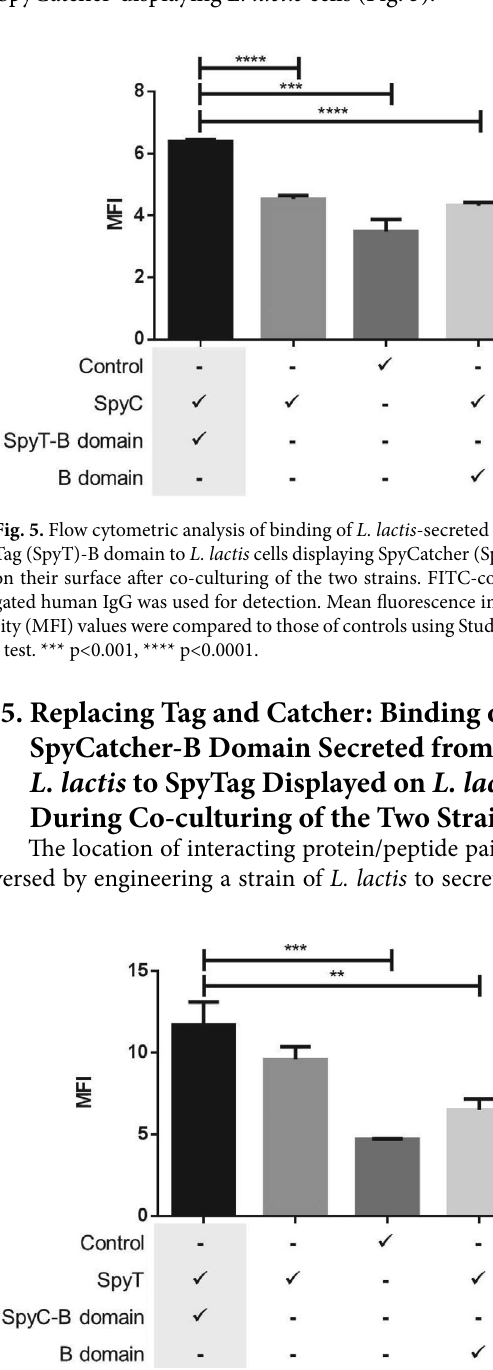
Fig. 6. Flow cytometric analyses of binding of L. lactis- secreted Spy- Catcher (SpyC)-B domain to L. lactis cells displaying SpyTag (SpyT) on their surface. FITC-conjugated human IgG was used for detec- tion. MFI: Mean fluorescence intensity. MFI values were compared to those of controls using Student’s t test. ** p < 0.01, *** p < 0.001.